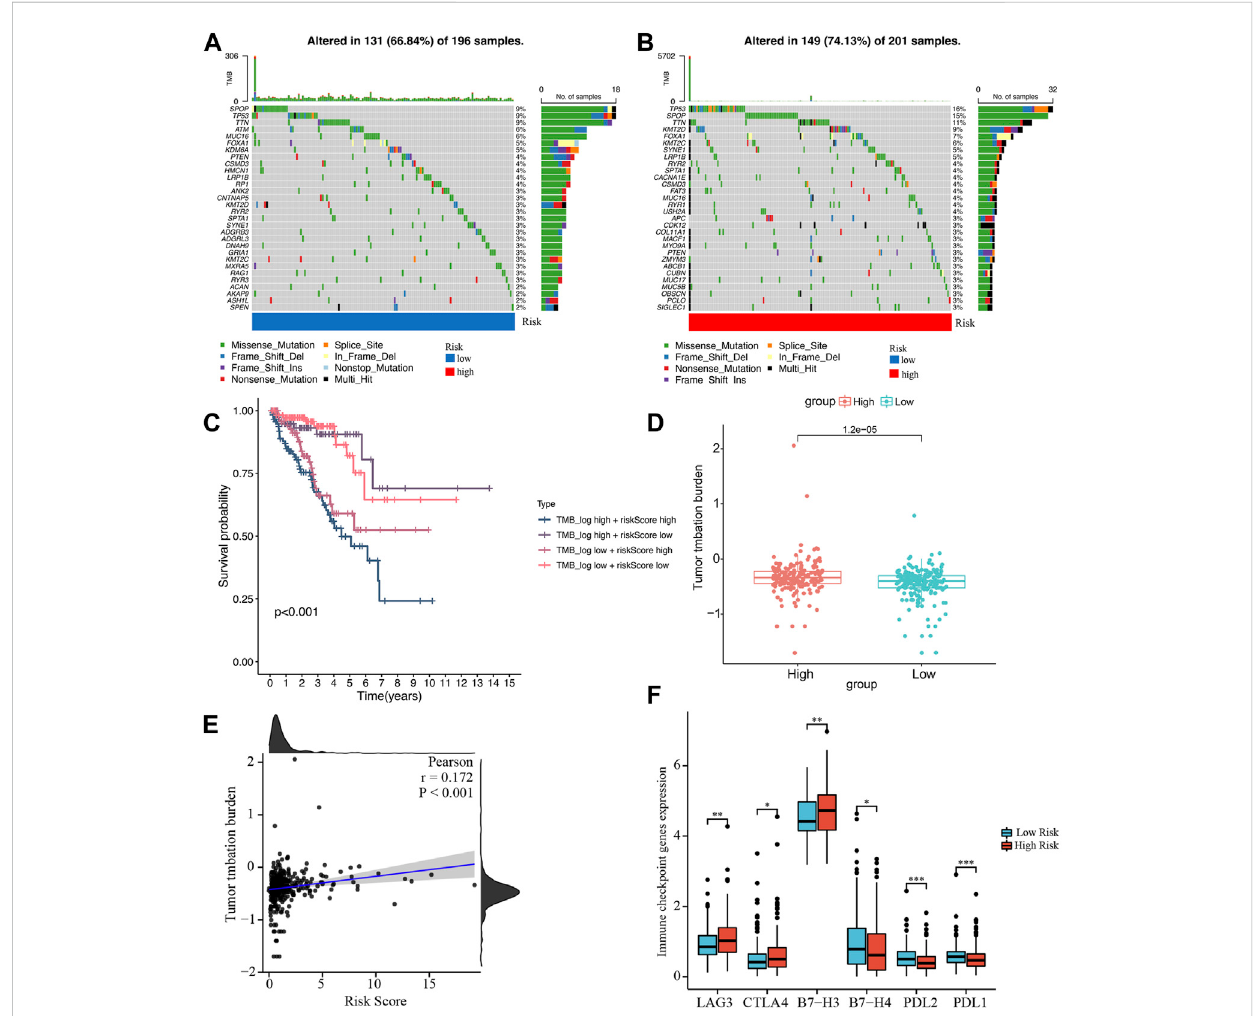
FIGURE 9 Analysis of tumor mutation burden and immune checkpoint genes. (A, B) Waterfall plots of mutated genes in the low- and high-risk groups, respectively. (C) Kaplan-Meier survival curve of BCRFS strati fi ed by TMB and risk score. (D) The comparison of TMB between the low- and high-risk groups. (E) The correlation between TMB and risk score. (F) Differentially expressed immune checkpoint genes between the low- and high-risk groups. * p < 0.05; ** p < 0.01; *** p <